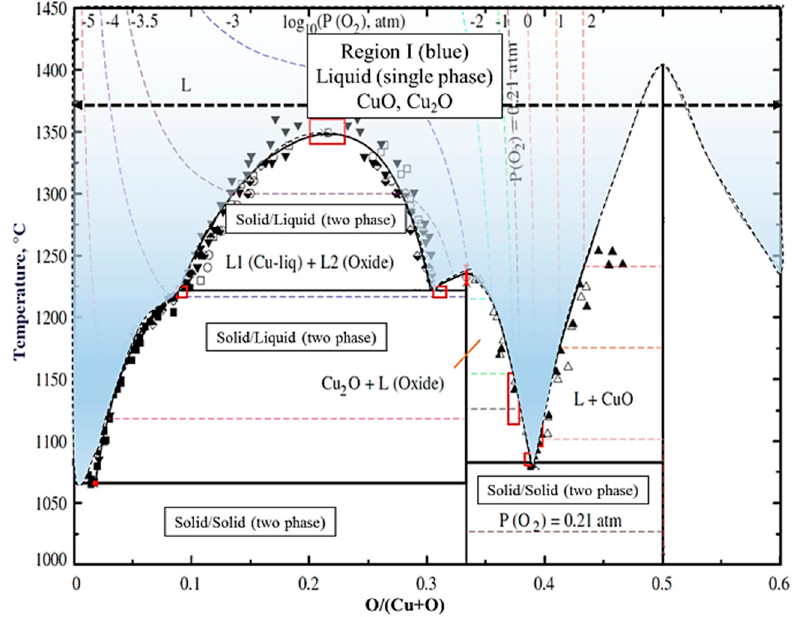
Figure 4. Phase diagram of molten copper oxide reproduced with permission from [24].